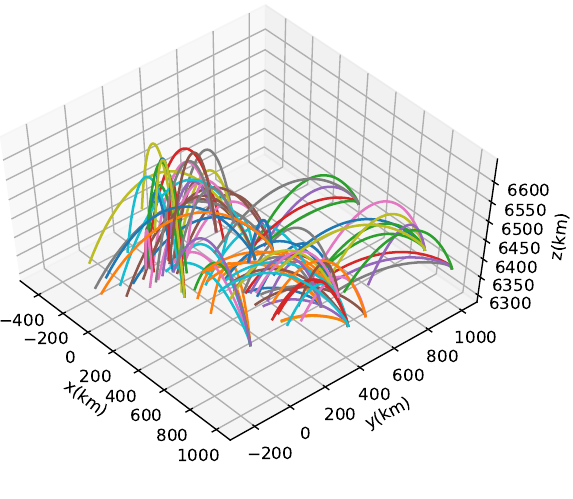
Figure 2. Randomly generated sample trajectories of ballistic